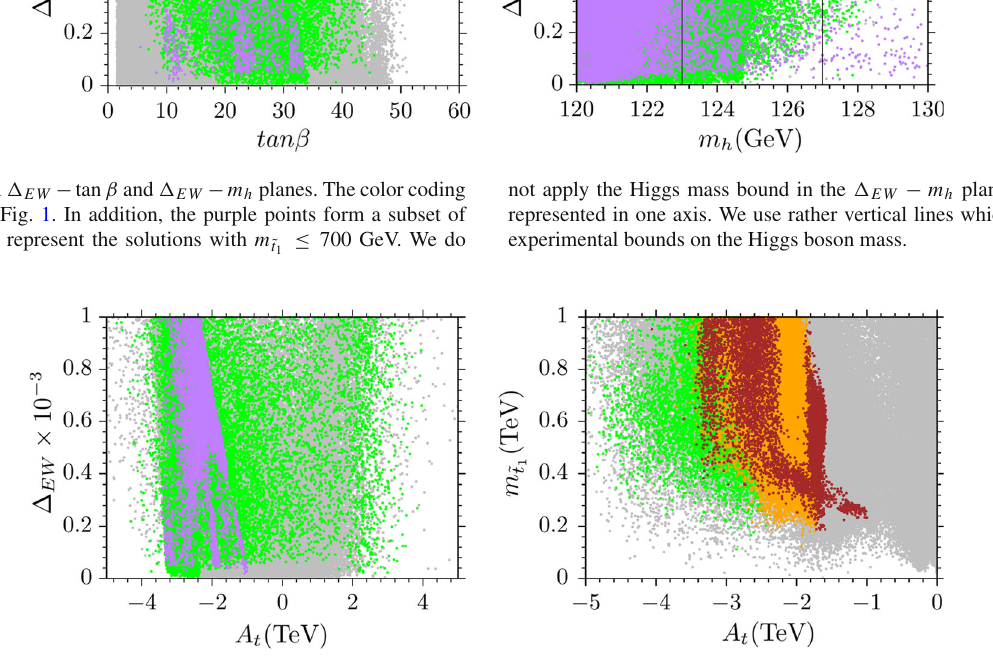
Fig. 3 Plots in (cid:2) EW − A t and m ˜ t left panel is the same as Fig. 1. While the meaning of gray and green are the same in the right panel, the orange points represents the solutions